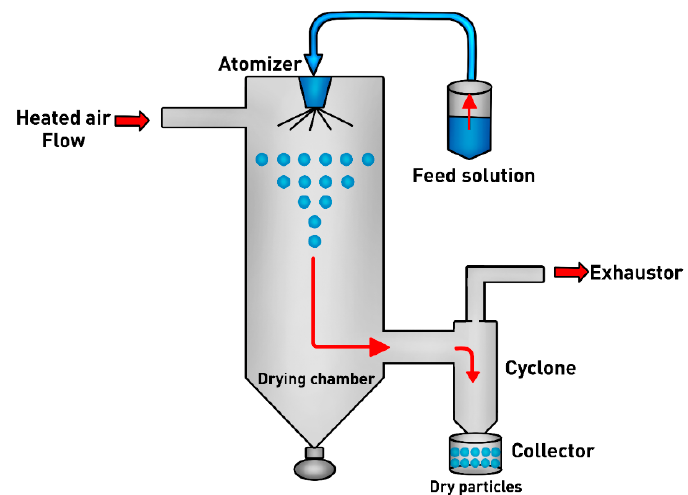
Figure 3. Scheme of the spray-drying process for dry particles production. Adapted with permission from [46], Elsevier, 2015.